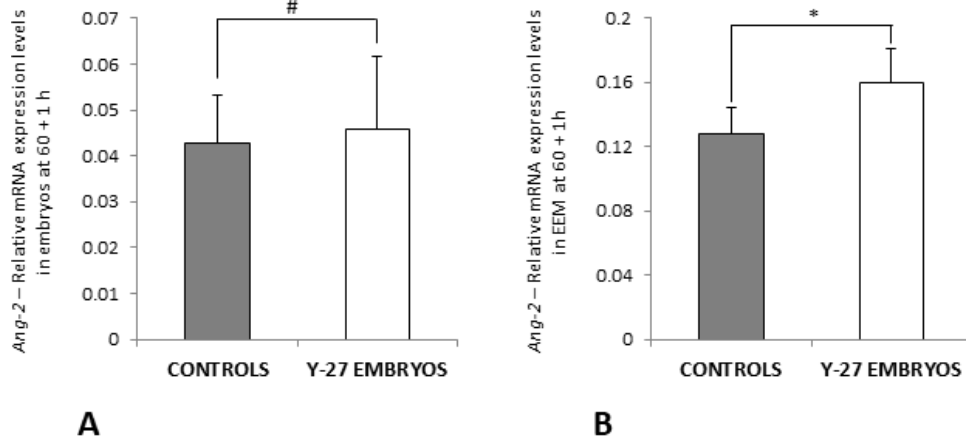
Figure 10. The relative mRNA expression levels of Ang-2 in embryos ( A ) and EEM ( B ) of the control group and Y-27632 (500 µM) treatment group at 60 + 1 h. The expression levels of Ang-2 at 60 + 1 h were not different between controls and Y-27632-treated embryos ( A , # p > 0.05) but were significantly higher in membranes of the treatment group when compared to the control group ( B , * p < 0.05). The vertical bars represent the SD. y-axis : Relative mRNA Expression Levels.